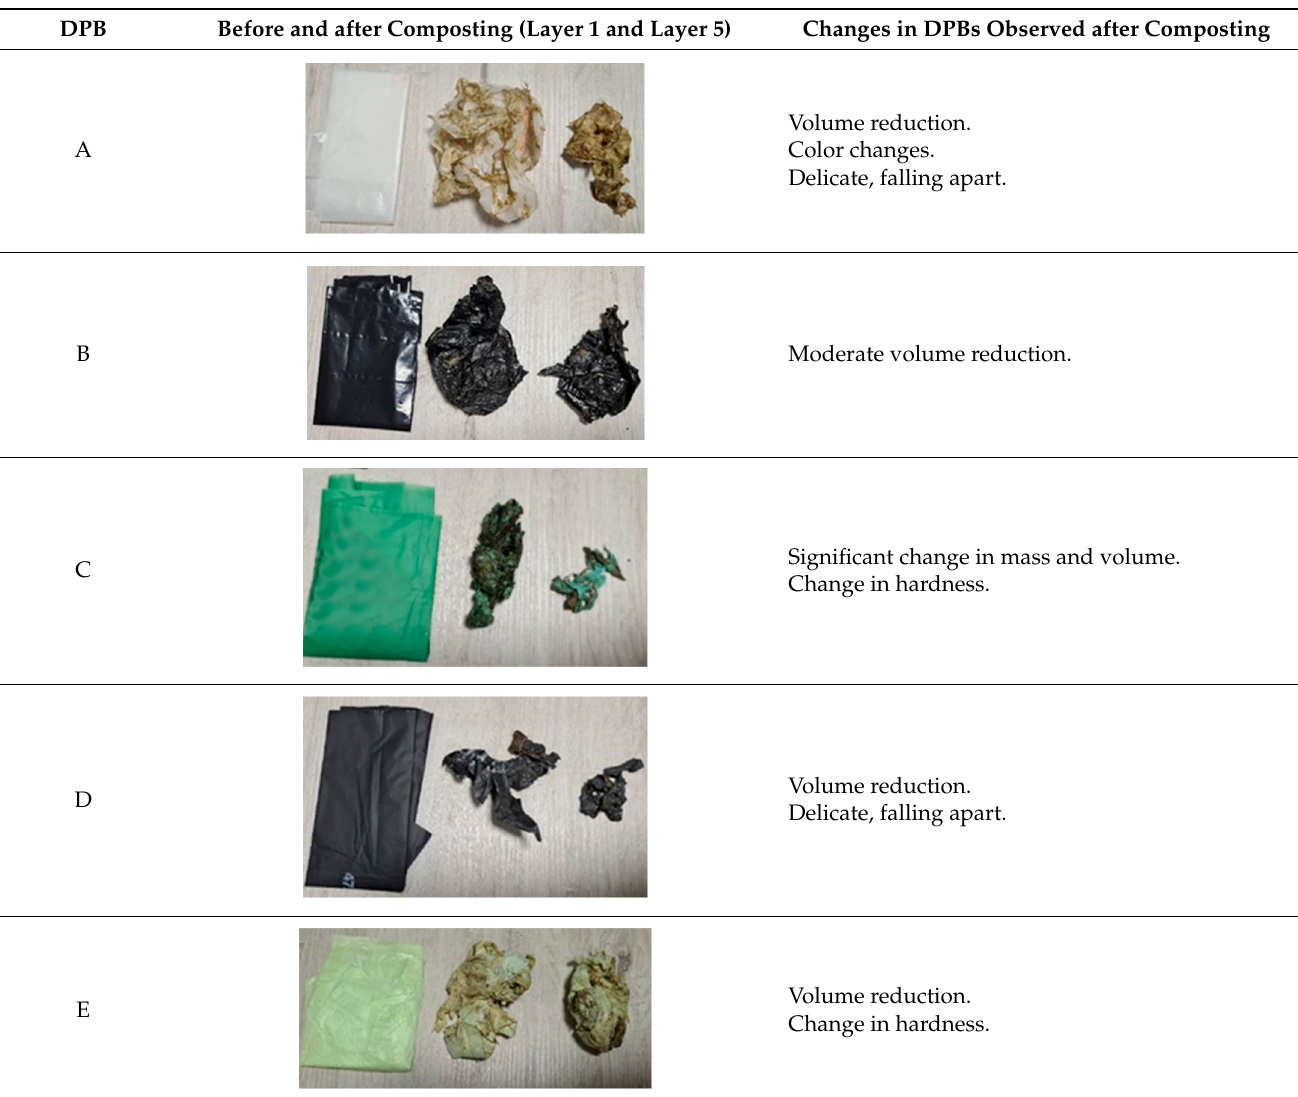
Table 6. Characteristics of DPBs after the 4-week composting.